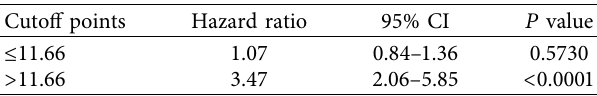
Figure 2: The nonlinear relationship between Log2 NT-proBNP and MACE. Table 4: Piecewise linear regression model was used to detect the association of Log2 NT-ProBNP and MACE according to the Log NT-proBNP cutoff